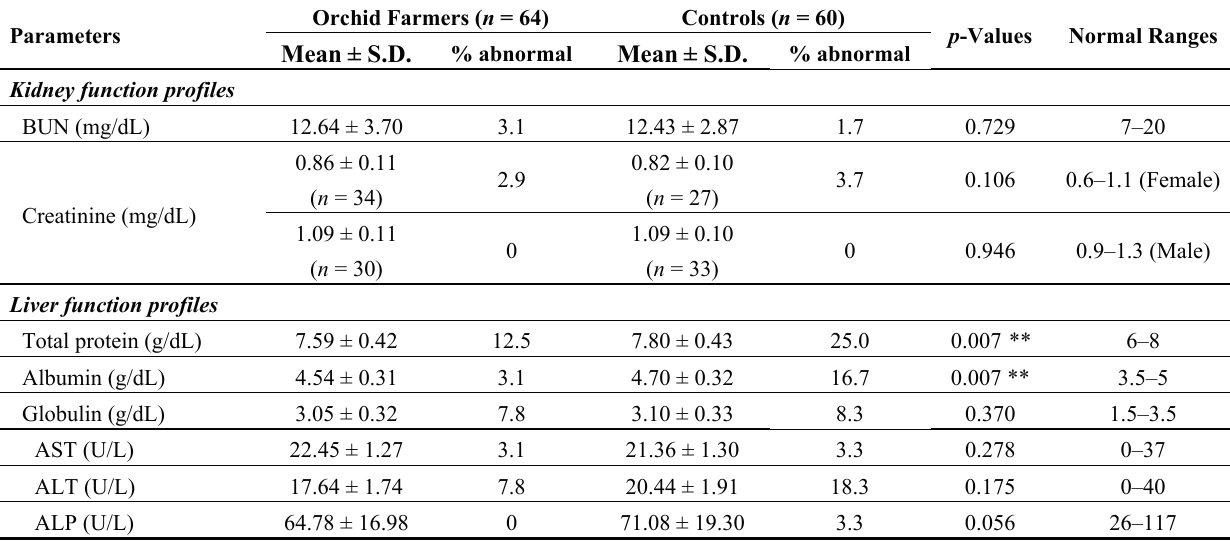
Table 7. Levels of serum protein/factors in orchid farmers and in controls (Mean ± S.D.).